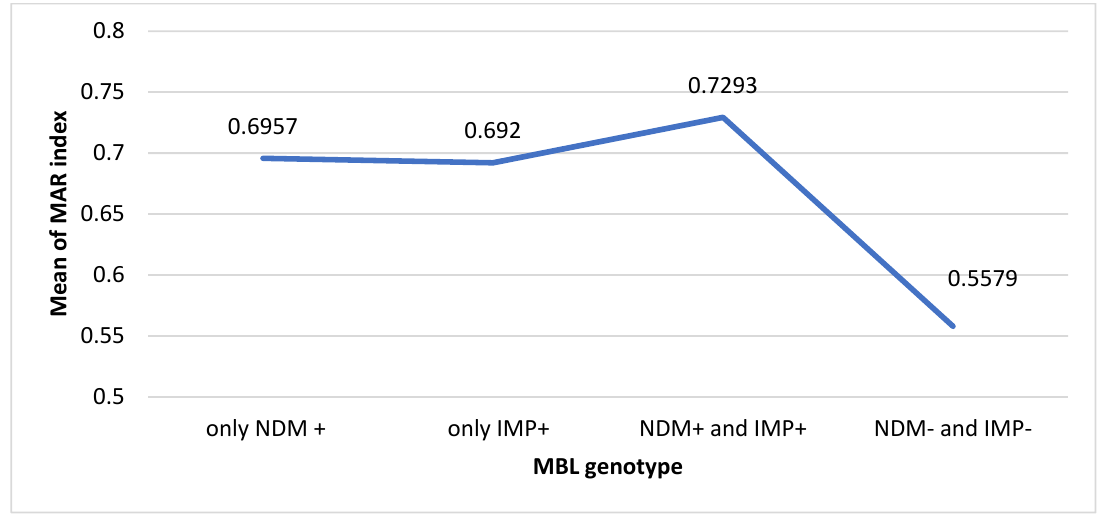
Figure 4. Distribution of MAR index mean values ( 𝑥̅ ) among the detected MBLs genotypes